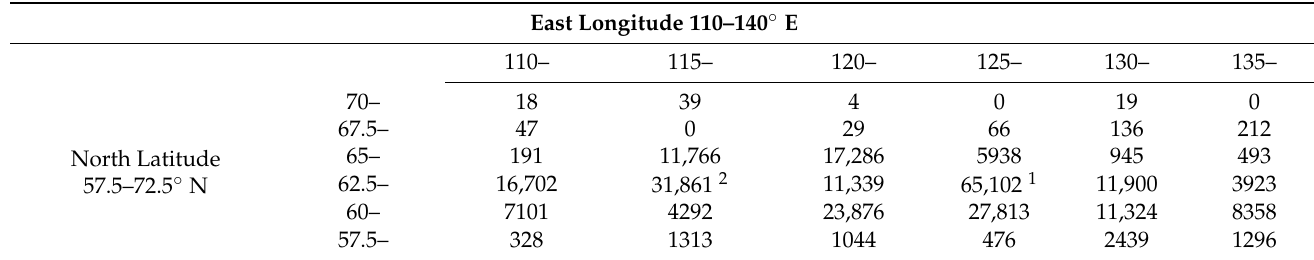
Table 1. Hotspot (HS) distribution in Sakha in 2021 until 9 September.